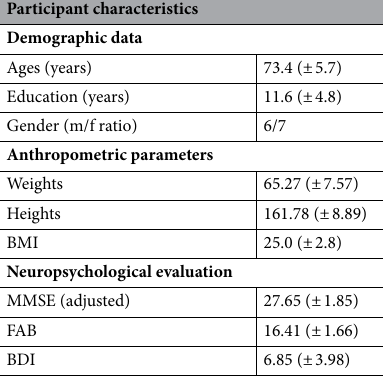
Table 1. Demographic, anthropometric and neuropsychological participants’ characteristics (mean ± standard deviation). Weights in kilograms, heights in centimetres, body mass index (BMI), mini mental